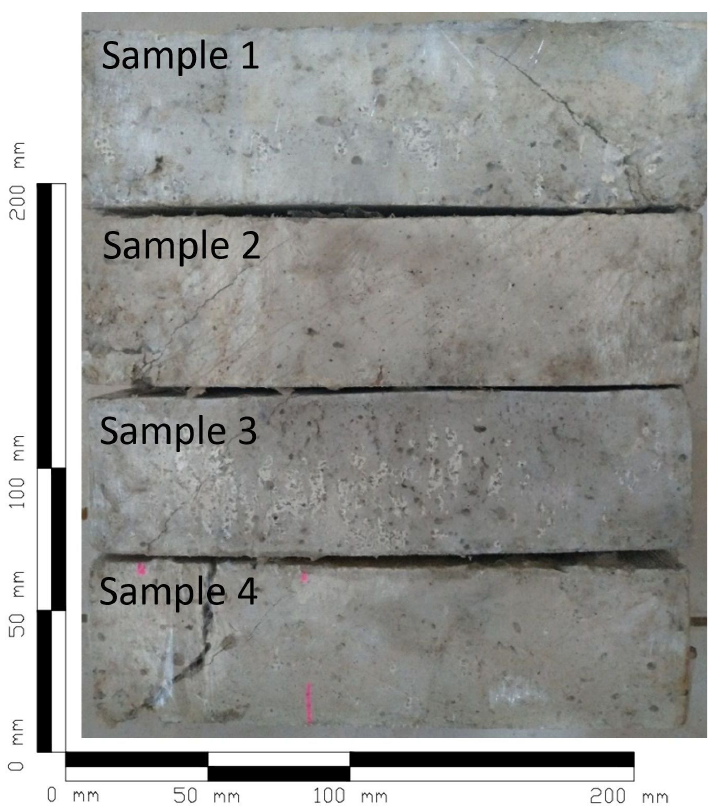
Figure 14. Cracking propagation behavior of reinforced concrete beams (Samples 1 to